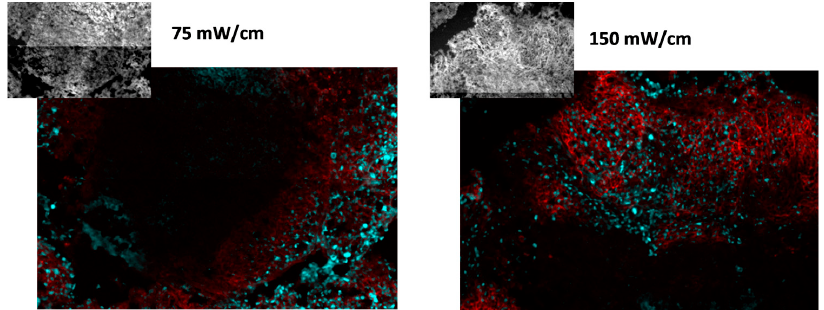
Figure 5. EFGR activation is associated with proliferating cells. Proliferation is identified by Ki-67 (cyan) and EGFR activation by phosphorylated EGFR (pEGFR; red). Tumor cells are identified by RFP, shown in the insets. Images represent an area of 0.9 mm × 0.6 mm (photographed at 10× magnification). PDT was delivered at 75 or 150 mW/cm, 1 mg/kg HPPH. Intensity levels for pEGFR expression in Ki67-positive cells were quantified from images such